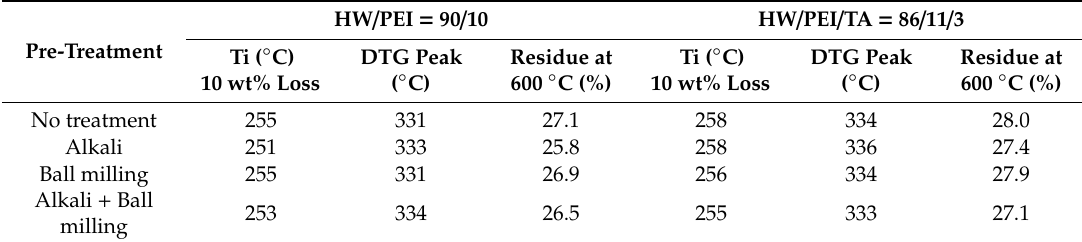
Table 4. TGA results of ECAP consolidated HW